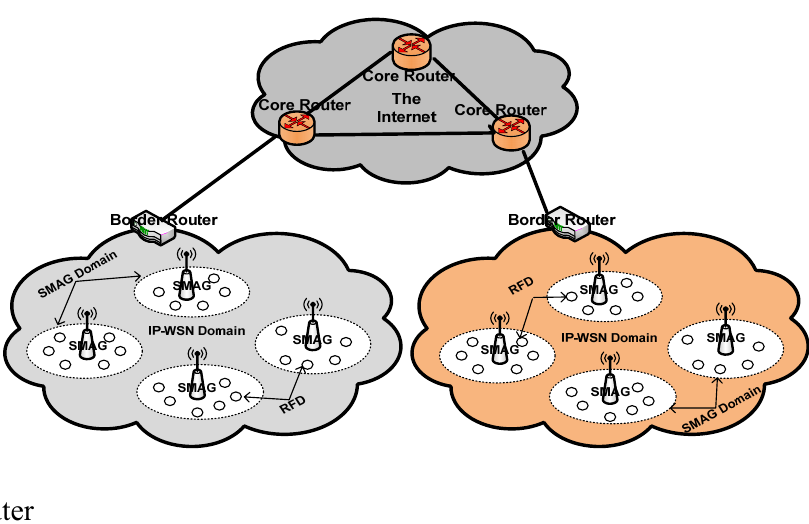
Figure 1. Global IP-WSN